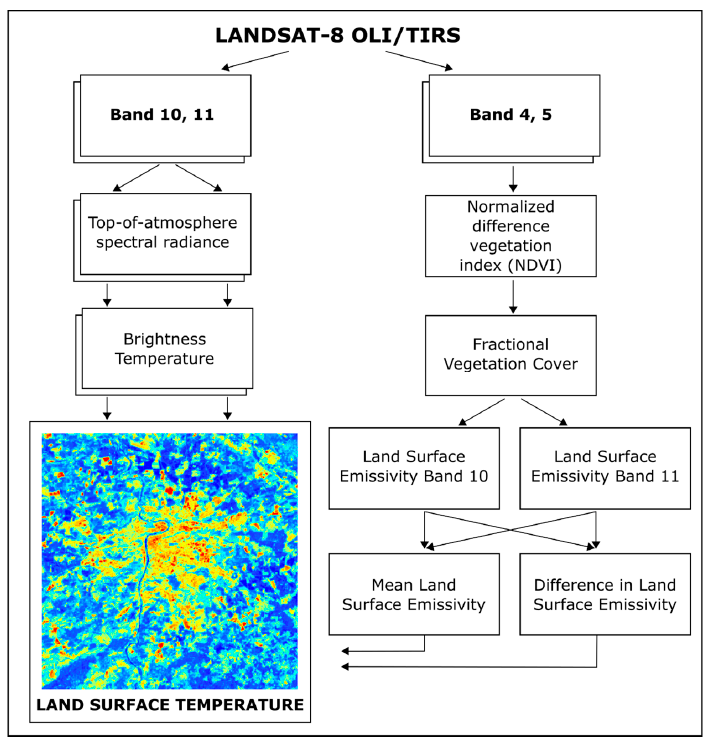
Figure 2. LST calculation from LANDSAT-8 OLI/TIRS images.